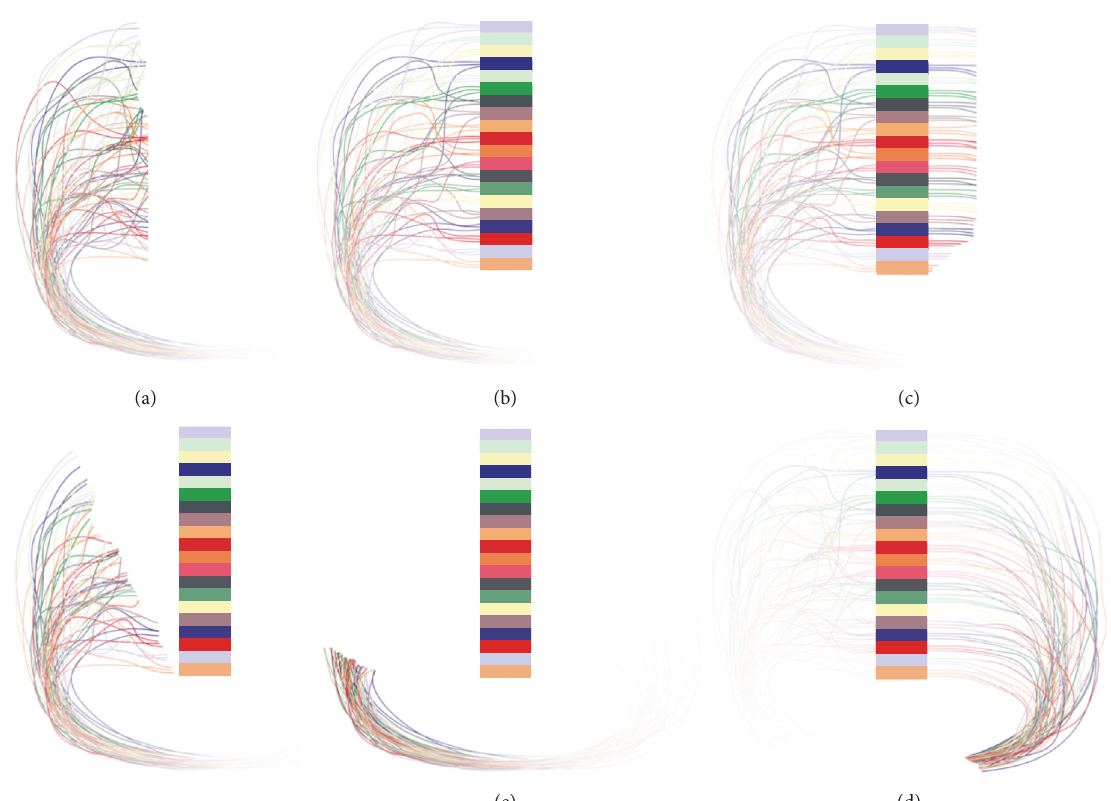
Figure 4: The cycle of social entropy and space, clockwise: from the high unpredictability of potential actions to a momentarily ordered system, as actions converge into places, only to dive in entropy